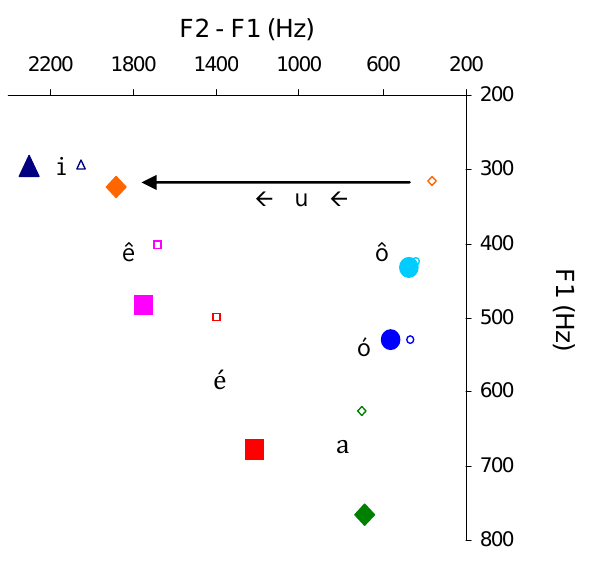
Figure 3: The Vowel Space of Sra. T, native and resident of Nordeste, S. Miguel (as reported in Silva